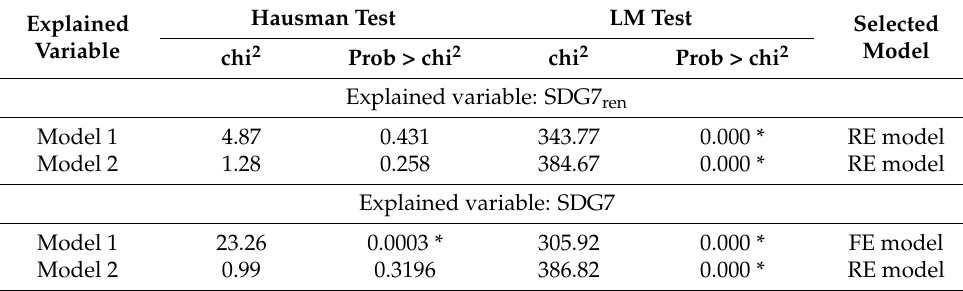
Table 6. The findings of the Hausmann and LM tests.